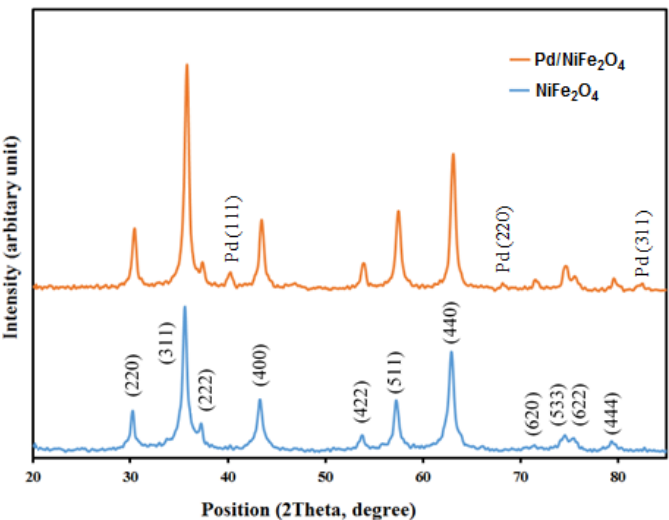
Fig. 2. XRD patterns of NiFe Fig. 2 . XRD patterns of NiFe 2 O 4 (a) and Pd/NiFe 2 O 4 nanocomposite (b).